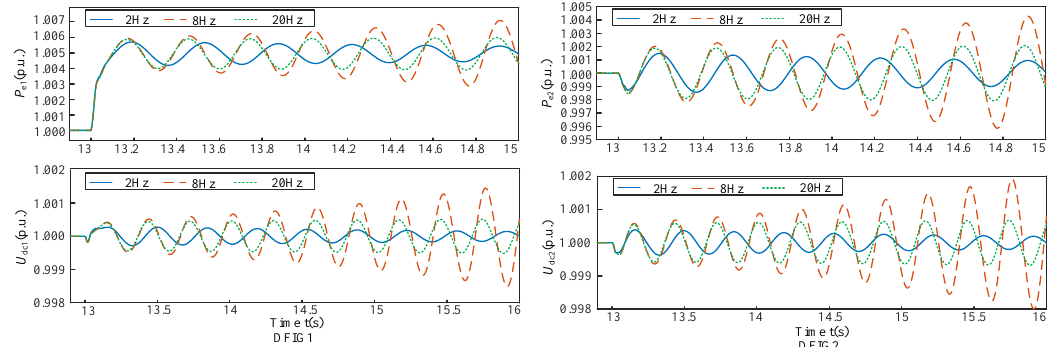
Figure 10. Active power outputs and DC-link voltages of the two-DFIG system for different bandwidths of PLL in DFIG1.